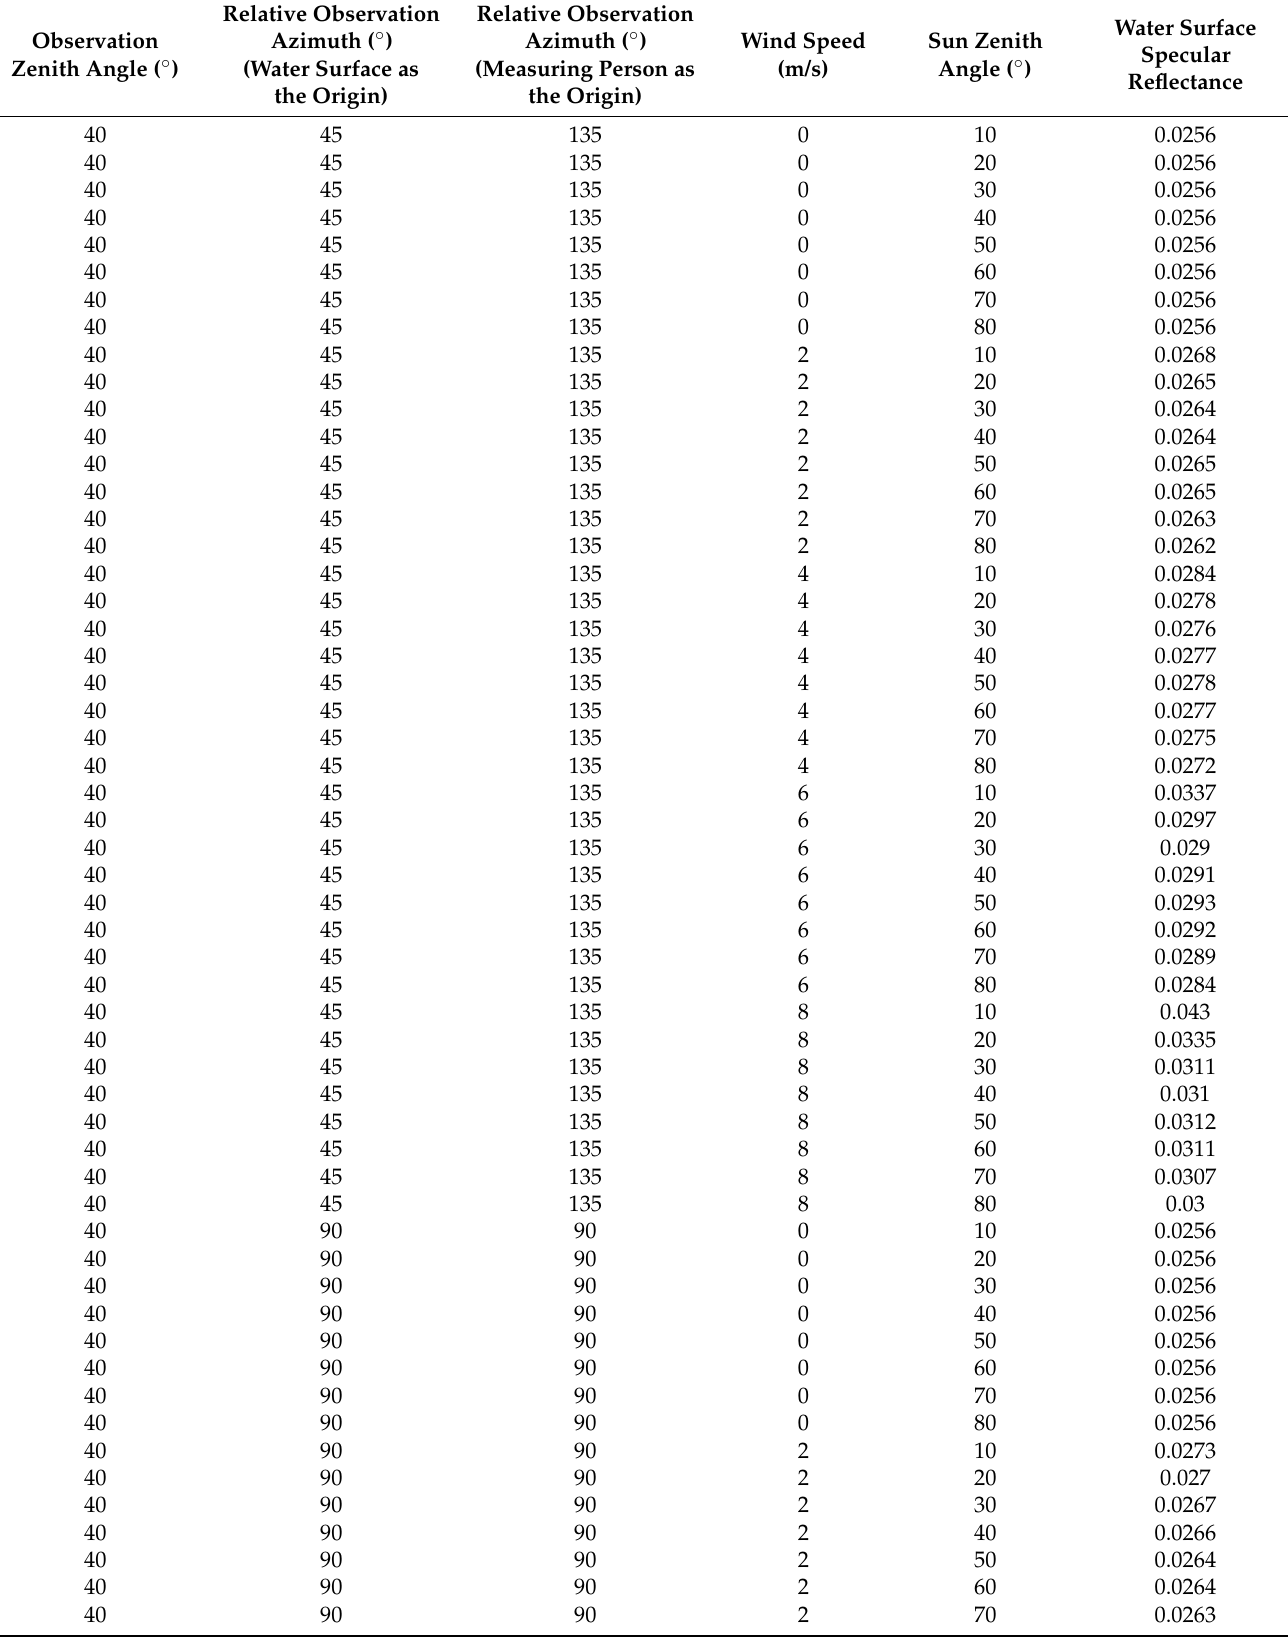
Table A2. Look-up table for the calculation of the specular reflectance of the water surface r sky